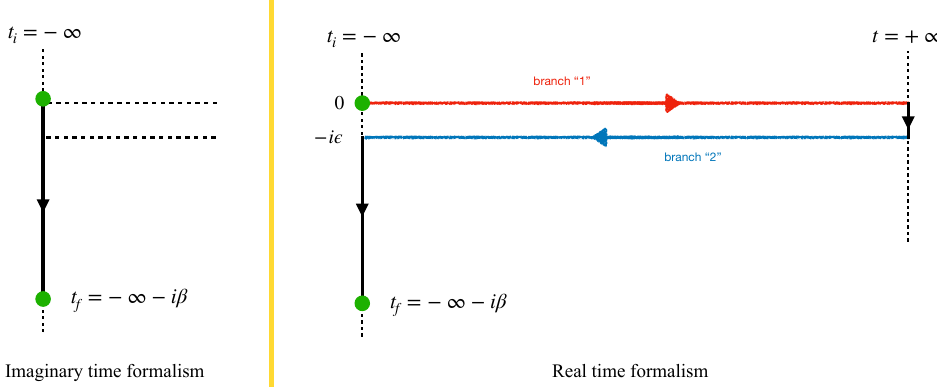
Figure 1. Left: (Imaginary) Time integration contour in the imaginary-time formalism, where the R D φ e − βH partition function is calculated by writing e − βH using a path integral representation, as one does in quantum mechanics for e − iHt , but with time going from t i = −∞ to t f = −∞ − iβ (the reference real time, in this case Re { t i } = Re { t f } = −∞ is arbitrary for time-independent observables). Right: the conventional Schwinger-Keldysh contour in the real-time formalism, where the imaginary-time path is deformed to allow for insertions of operators at arbitrary real times. To close the path and allow for insertions at an arbitrary real time, it is necessary to go from t = −∞ to t = + ∞ and back. From the real time t point of view, there are two copies of the fields: one in a time-ordered branch (branch 1, in red) and the other in an anti-time-ordered branch (branch 2, in blue). Both contours are “closed” in the sense that the field configurations at the initial t i and final time t f are identified when taking the trace